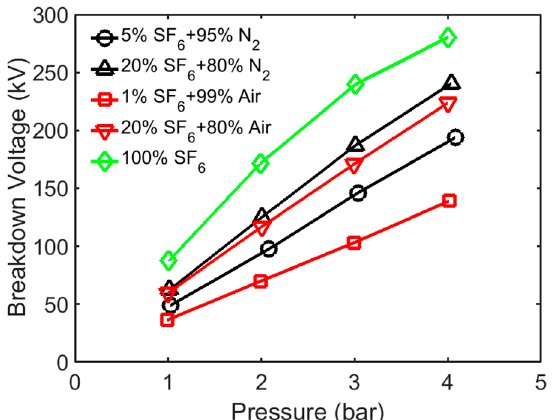
Figure 2. Measured Direct Current breakdown voltages in SF 6 + N 2 and SF 6 + Air mixtures as a function of gas pressure for a uniform electrode gap of 10 mm [17].